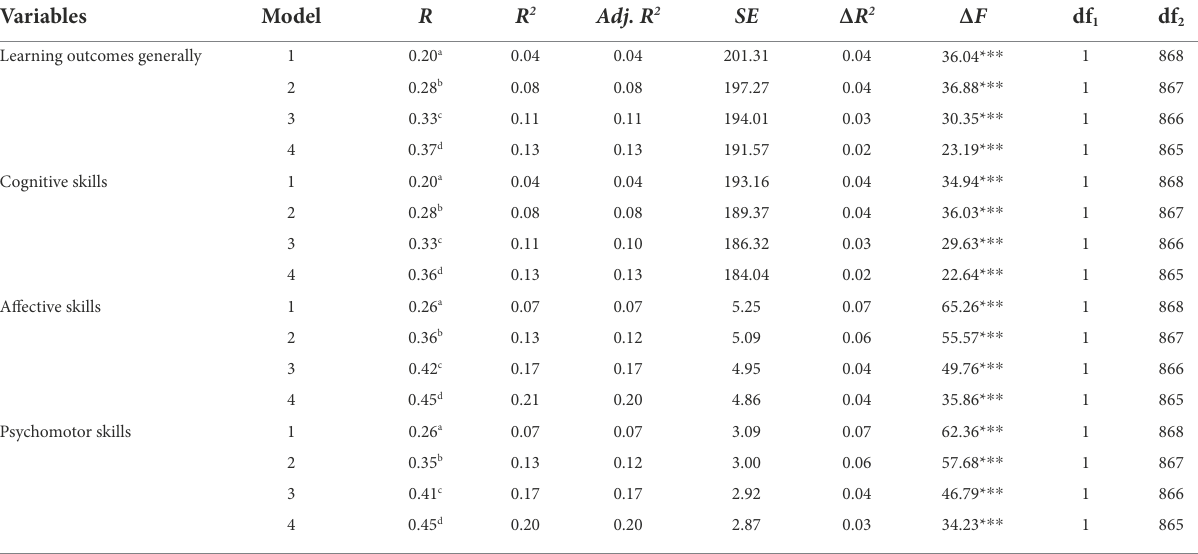
TABLE 3 Hierarchical regression results summary of the relative and composite contributions of students’ inputs to learning outcomes generally and in terms of CAPs.